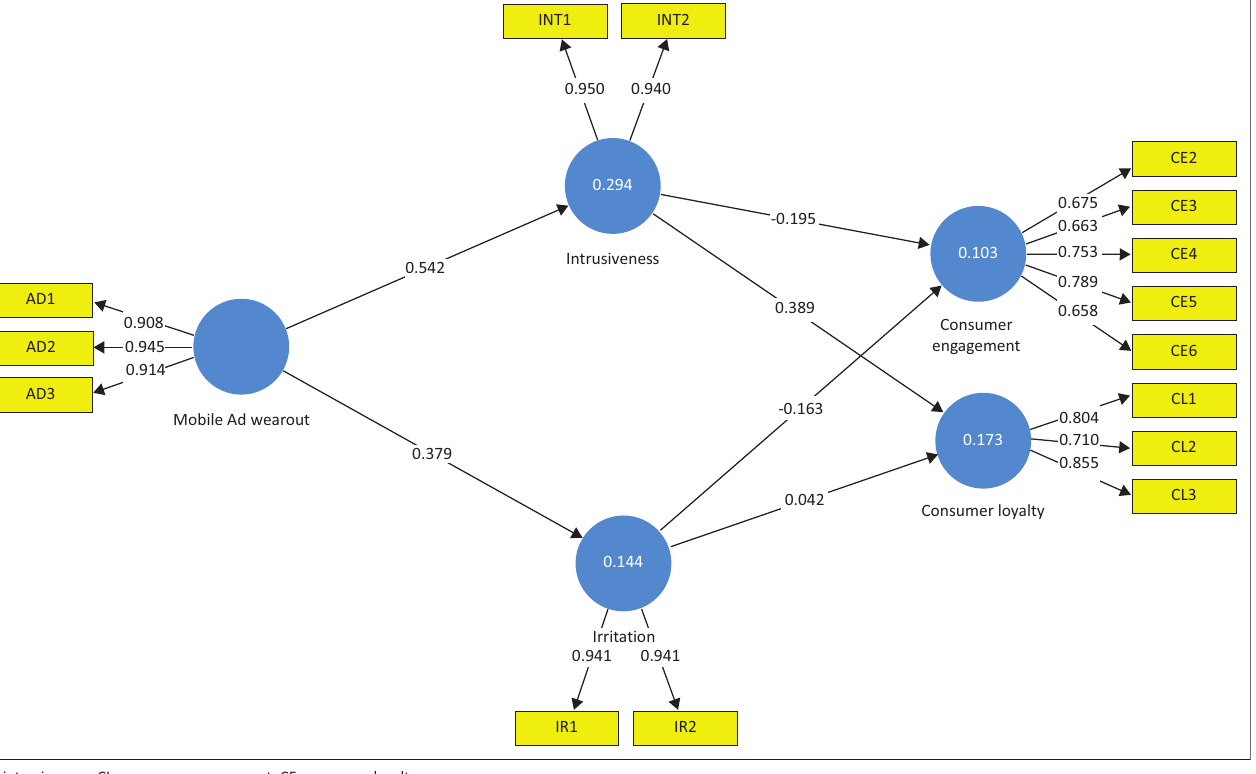
FIGURE 1: Factor loadings of the indicators, beta, and R 2